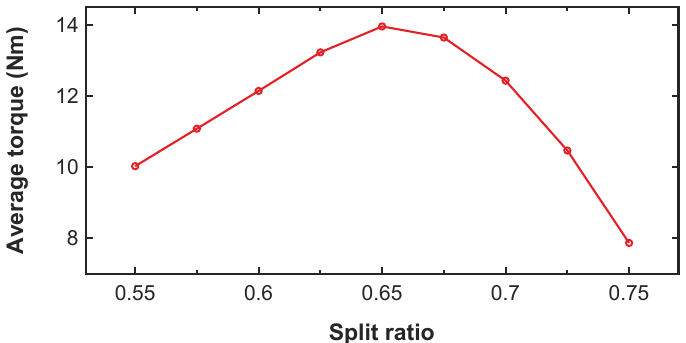
Figure 11. Relationship between split ratio and average torque.